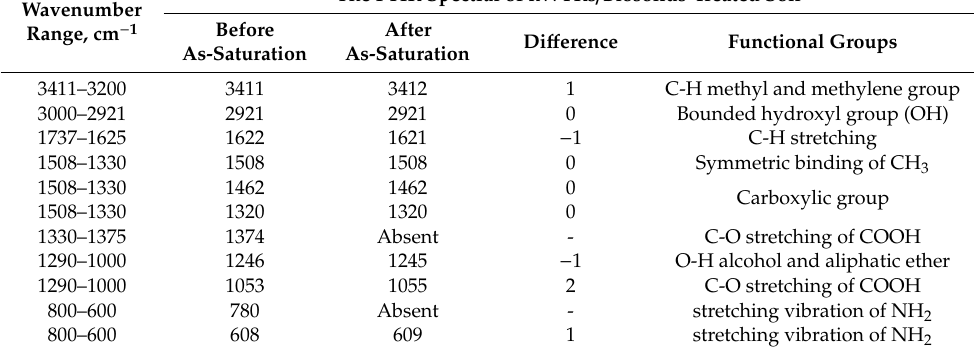
Table 2. The FTIR spectral characteristics of 1% nWTRs / biosolids-treated soil before and after As sorption (with initial As concentration of 800 mg / L).